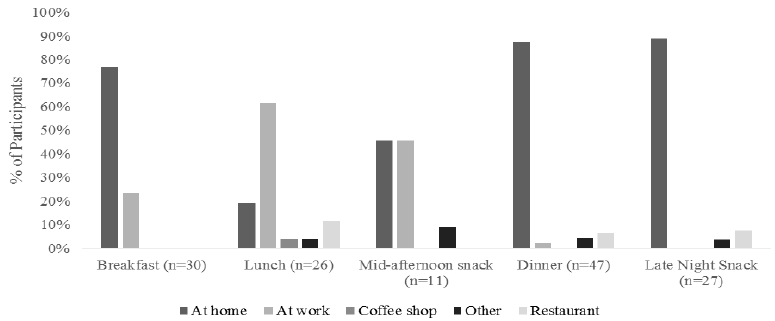
Figure 2. Number of items consumed during each eating occasion by participants in the study.